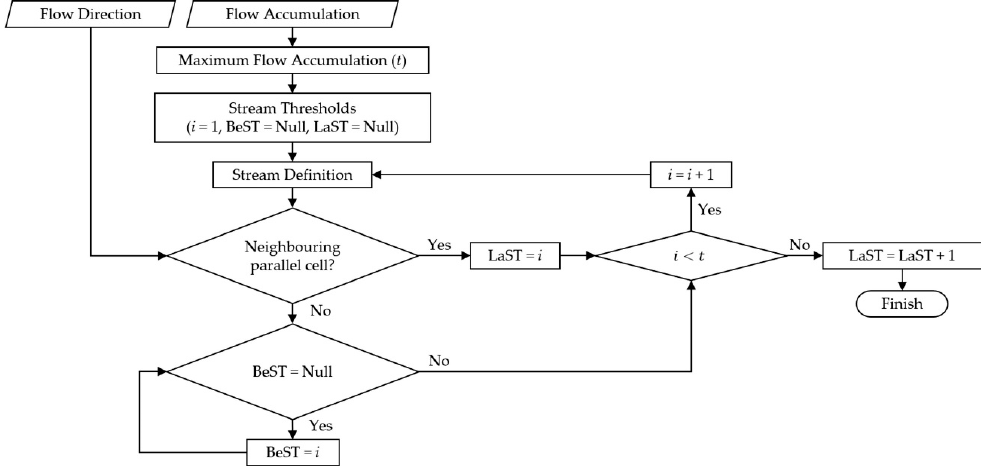
Figure 3. The flowchart of the algorithm.